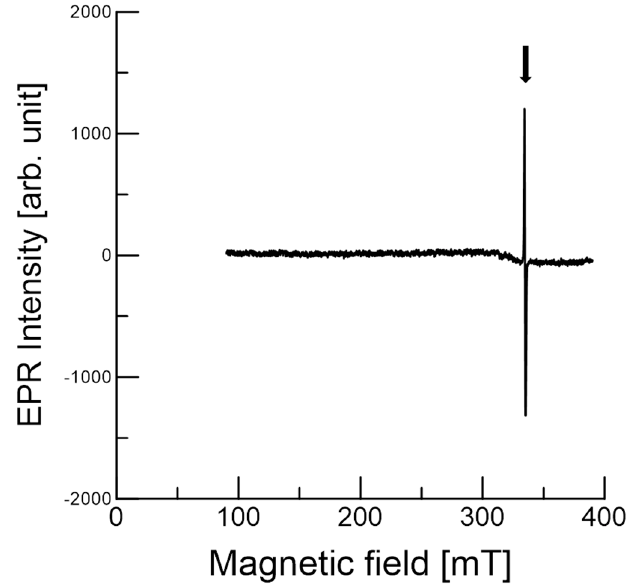
Figure 4. Electron paramagnetic resonance (EPR) spectra of a whole C. japonica seed at ambient temperature. The magnetic field center was 240.0 mT, with a 300 mT scan width. Each spectrum was obtained with a single scan. The arrow indicates the stable organic radicals.